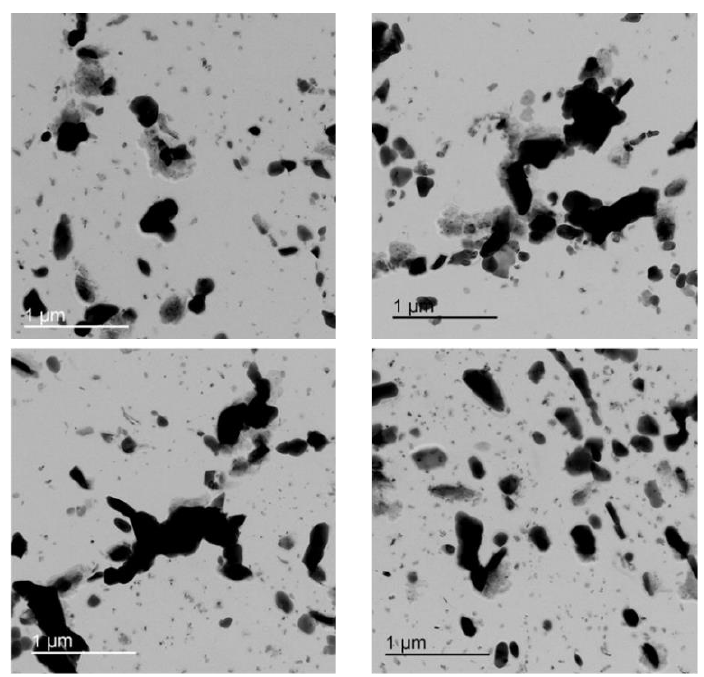
Figure A9. Failed crept cross-weld specimen 91-HAZ-3-6 600 °C 99 MPa 4280 h (sample C). TEM images on a carbon extraction replica at 50,000X.